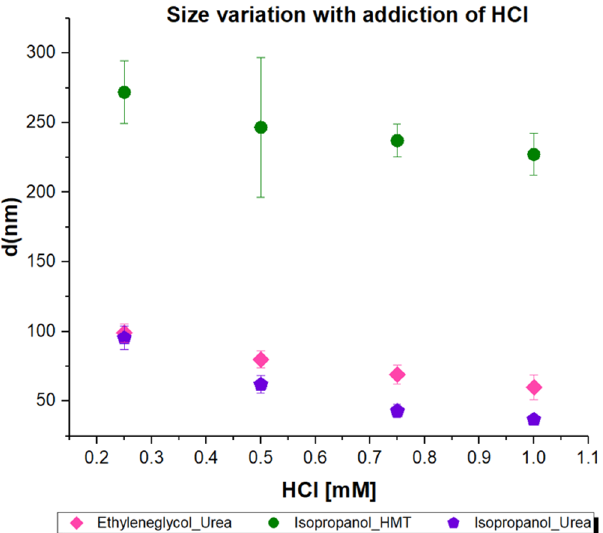
Figure 5. Diameter variation dependent on concentration of HCl added to the three series of syn- thesis.